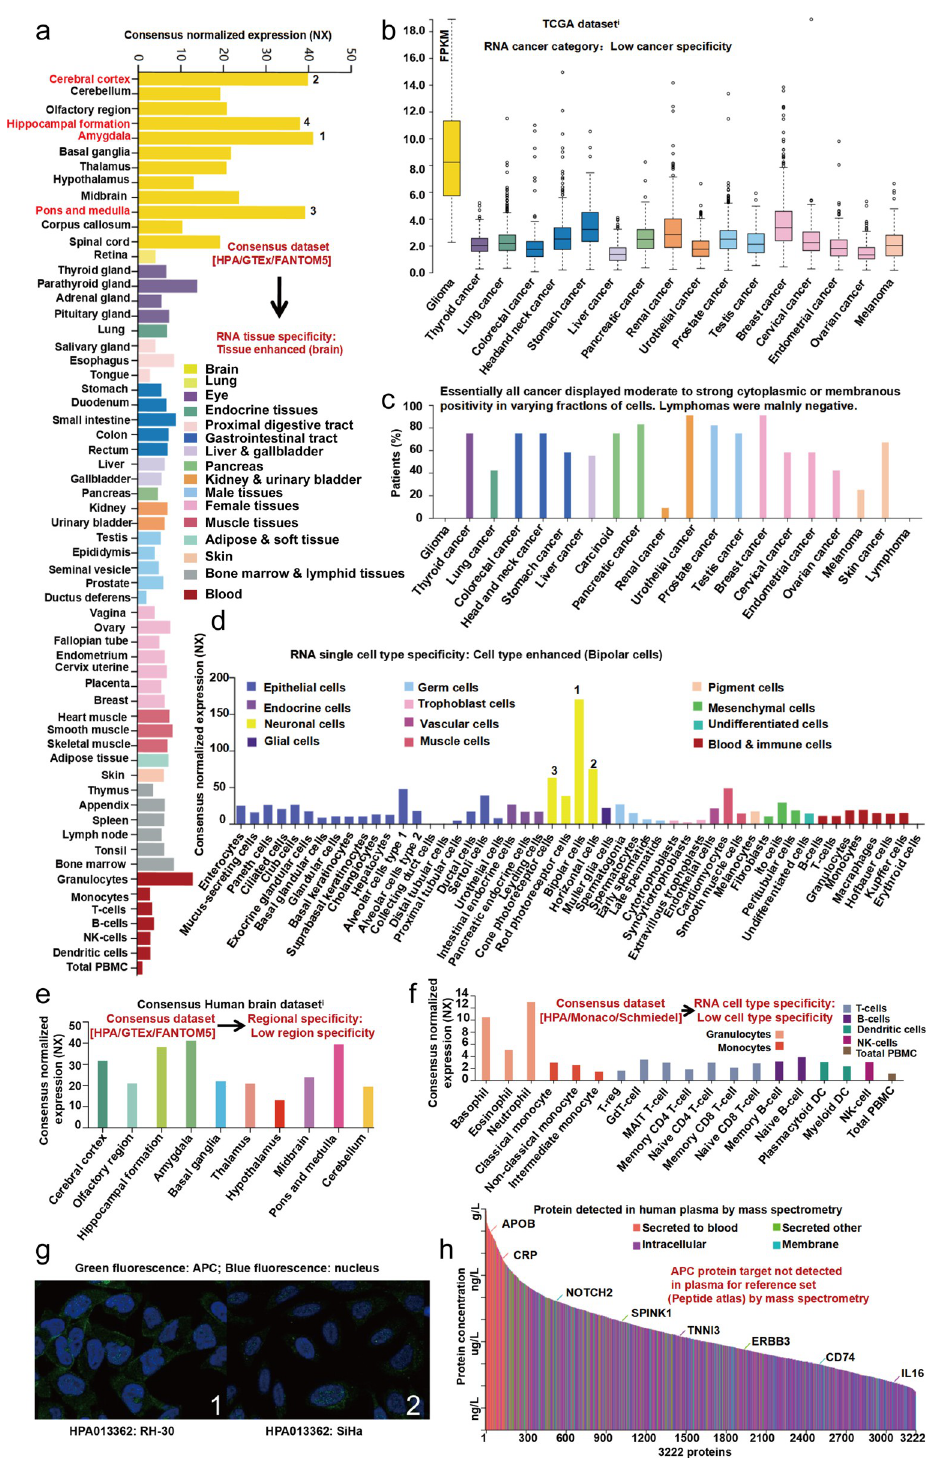
Fig 2. APC gene expression analysis. (a) Expression of the APC gene in various tissues. (b) Specificity expression of APC in RNA cancers. (c) Distribution of APC in cancer cells. (d) Specificity expression of APC in RNA single cells. (e) Distribution of APC in various human brain regions. (f) Expression of the APC gene in various blood cells. (g) Image of distribution of APC in cells. (h) The APC expression level in plasma based on the data of mass spectrometry.